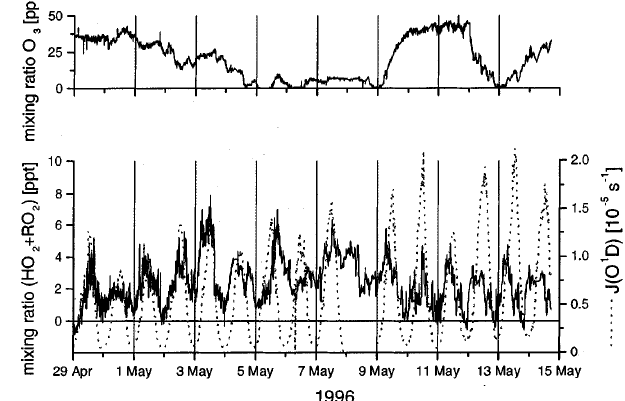
Fig. 9. The main ozone depletion event, ARCTOC 1996: O 3 , RO x - box signals (calibrated corresponding to RO x (cid:135) HO x , solid line ) and J(O 3 (O 1 D)) ( dotted line )